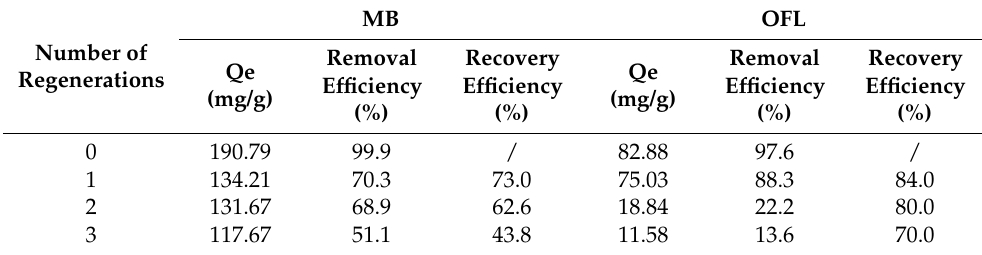
Table 3. SAC regeneration